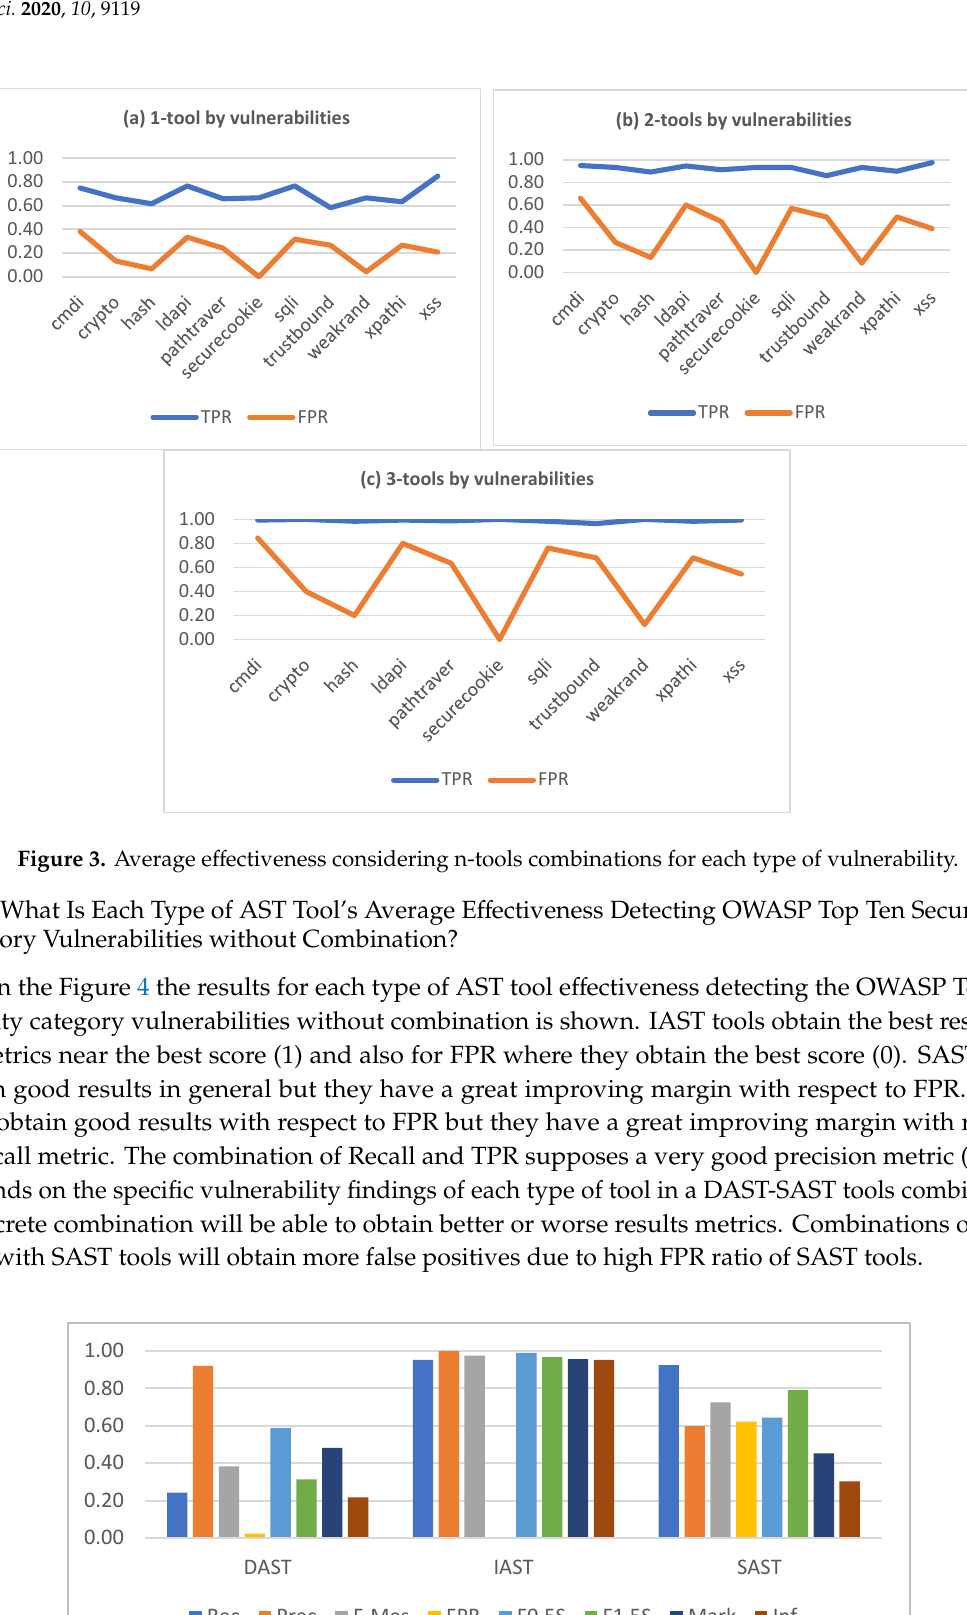
Figure 4. Tools metrics comparison without combination.